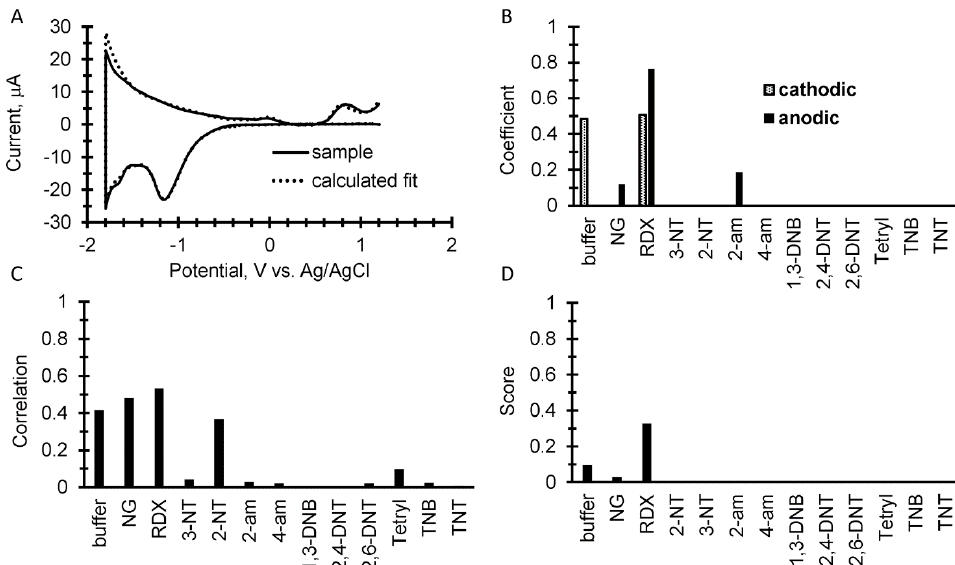
Figure 6. 10 µg of RDX wiped from a bench top. ( A ) An overlay of the background subtracted cyclic square wave voltammogram with the calculated fits of both the anodic and cathodic sweeps using coefficients from the explosive’s library. ( B ) A plot of the resulting coefficients from the fitting calculation for the result shown in A. ( C ) The correlation calculation comparing the measured sample to the square wave voltammetry library. ( D ) The score displayed as the product of the coefficients and correlations.